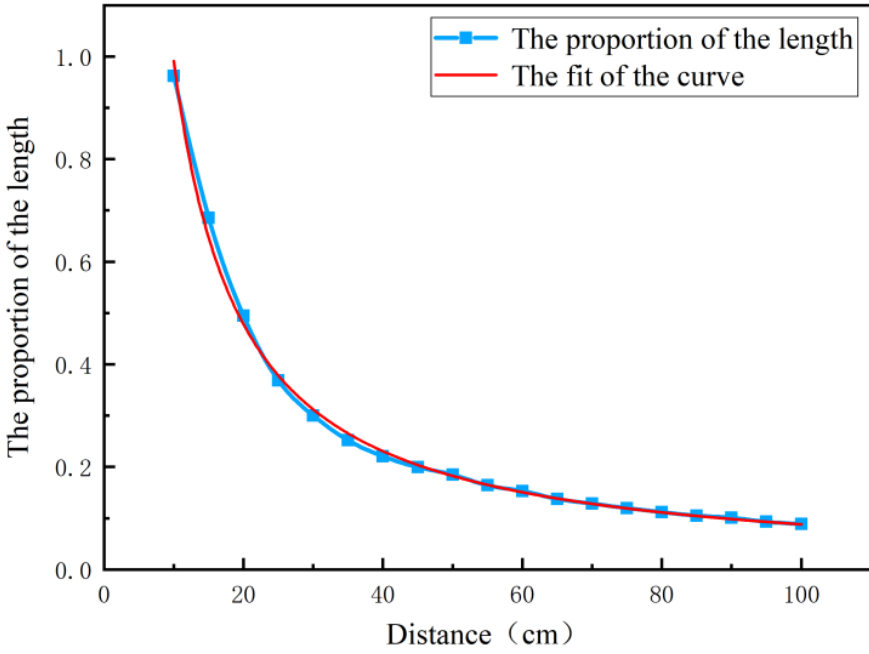
Figure 15. The results of the spacing test under different cumulative length ratios.